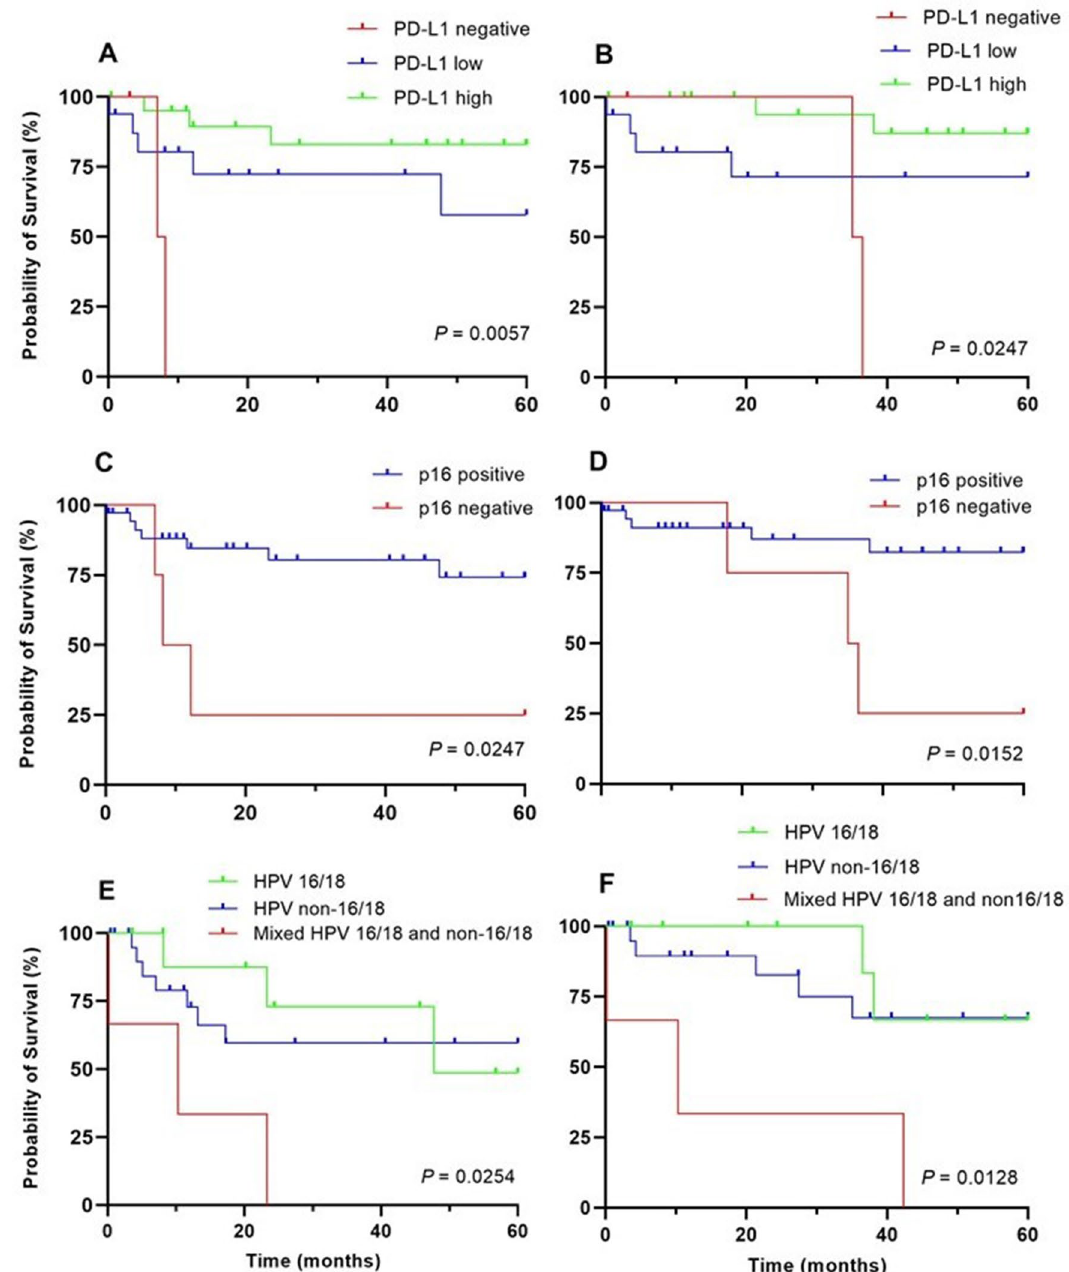
Figure 4. Five-year disease-free (DFS) and overall survival (OS) of patients with cervical cancer diagnosed at early clinical stage. ( A ) DFS based on negative, low and high PD-L1 expression. ( B ) OS based on negative, low and high PD-L1 expression. ( C ) DFS based on positive and negative p16 expression. ( D ) OS based on positive and negative p16 expression. ( E ) DFS based on HPV types. ( F ) OS based on HPV